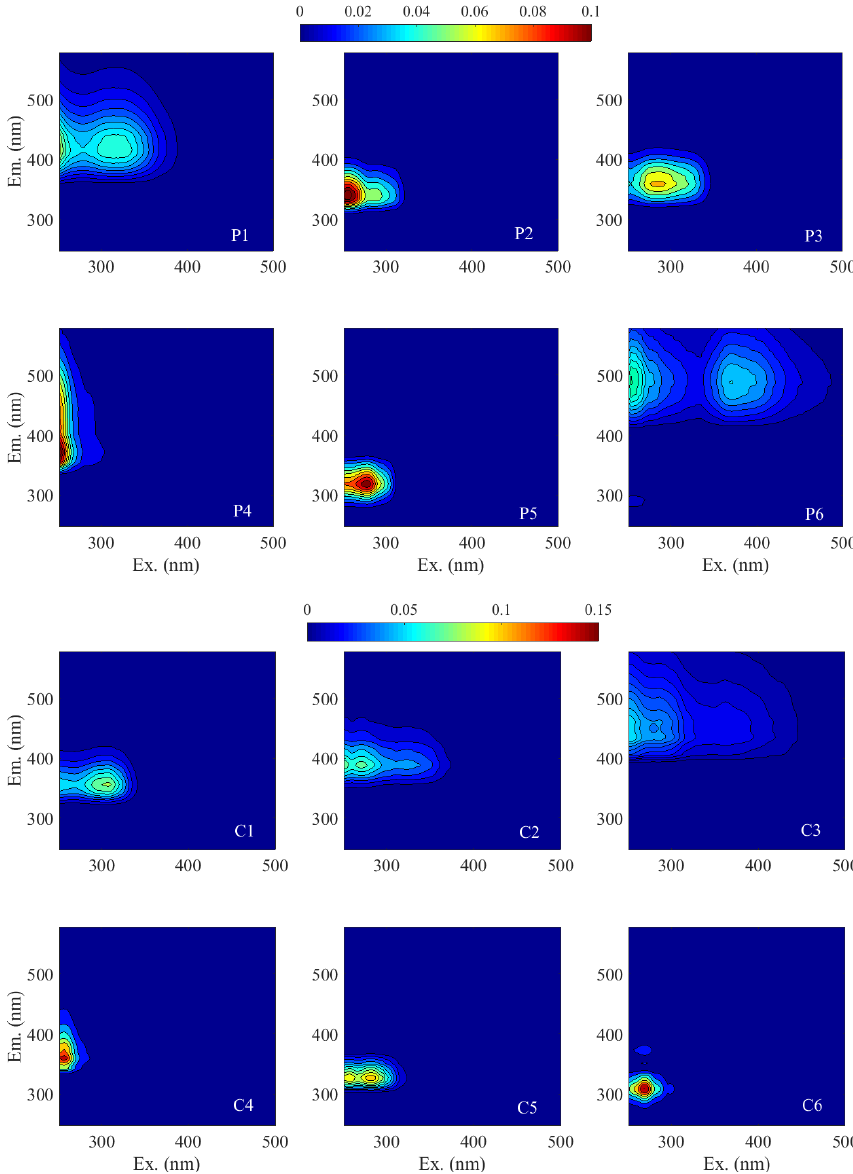
Figure 2. The EEM components identified by PARAFAC of WSOC (P1–6) and MSOC (C1–6) from the three origins. Em.: emission wavelength. Ex.: excitation